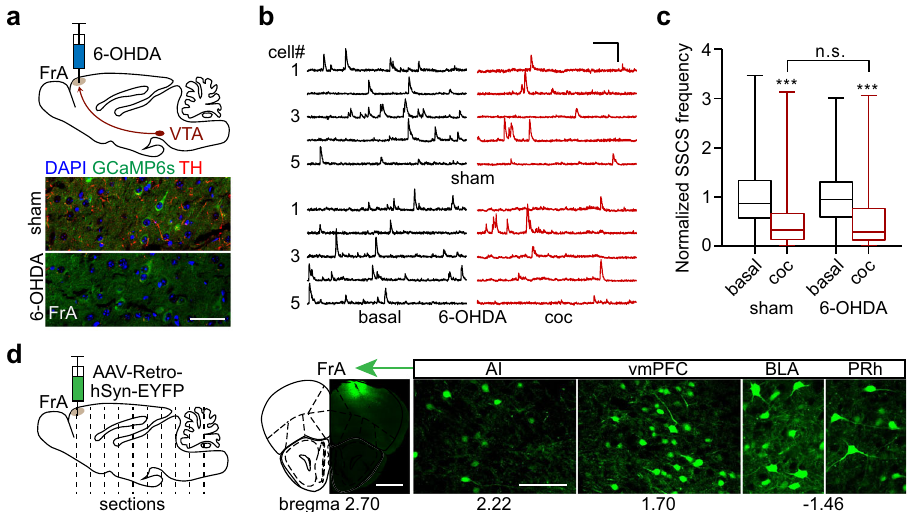
p =0.35 for coc (sham vs 6-OHDA), two-tailed Wilcoxon test for paired and Mann – Whitney test for unpaired comparisons, *** p <0.001. d Left, schematic of AAV-Retro-hSyn-EYFP injection into the FrA for the retrograde labeling of FrA- projecting neurons. Right, representative micrographs of four regions with retrogradely-labeled somata (scale bars, 1mm for FrA, 100 µ m for projecting regions). AI agranular insular cortex, vmPFC ventromedial prefrontal cortex, BLA basolateral amygdaloid nucleus, anterior part, PRh perirhinal cortex. n =5 mice. Source data are provided as a Source Data fi